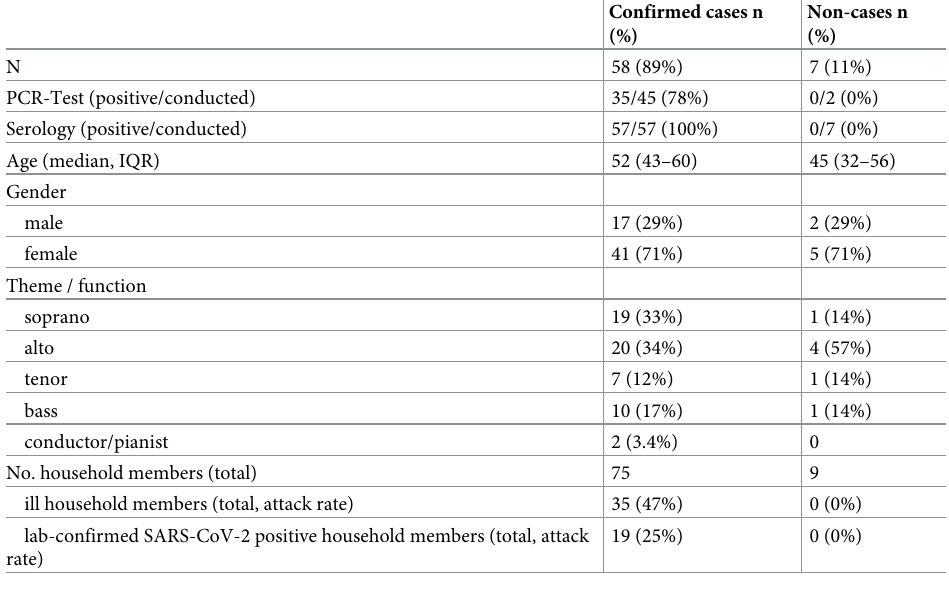
Table 2. Characteristics of cases (n = 58) and non-cases (n = 7) of the 09 March rehearsal of choir